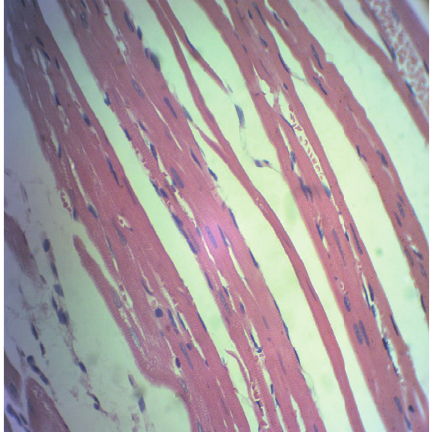
Figure 2: A cross-sectional representative of a DOX-intoxicated heart showing congested myocytes with scanty pyknotic and predominant hyperchromatic and meganuclei with interstitial fi- brosis, suggestive of myocardial hypertrophy ( × 400 magnification, hematoxylin-eosin stain).